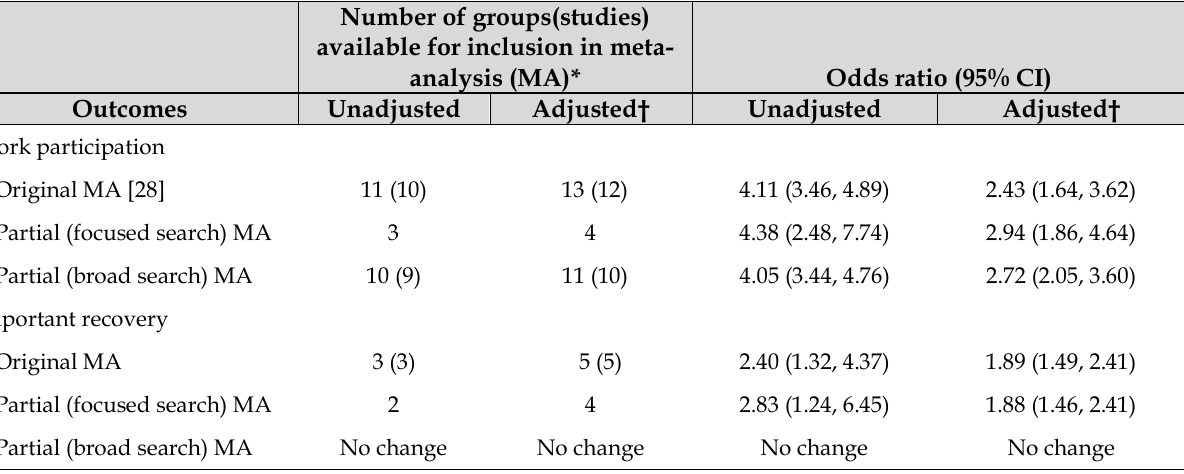
Table 2 Work participation and important recovery outcome results of Hayden et al.’s [28] original meta-analysis (“Original MA”), the partial meta-analysis including only studies identified using the focused electronic search strategy (i.e., no supplemental searches) (“Partial (focused search) MA”), and the hypothetical broad electronic search strategy (“Partial (broad search)